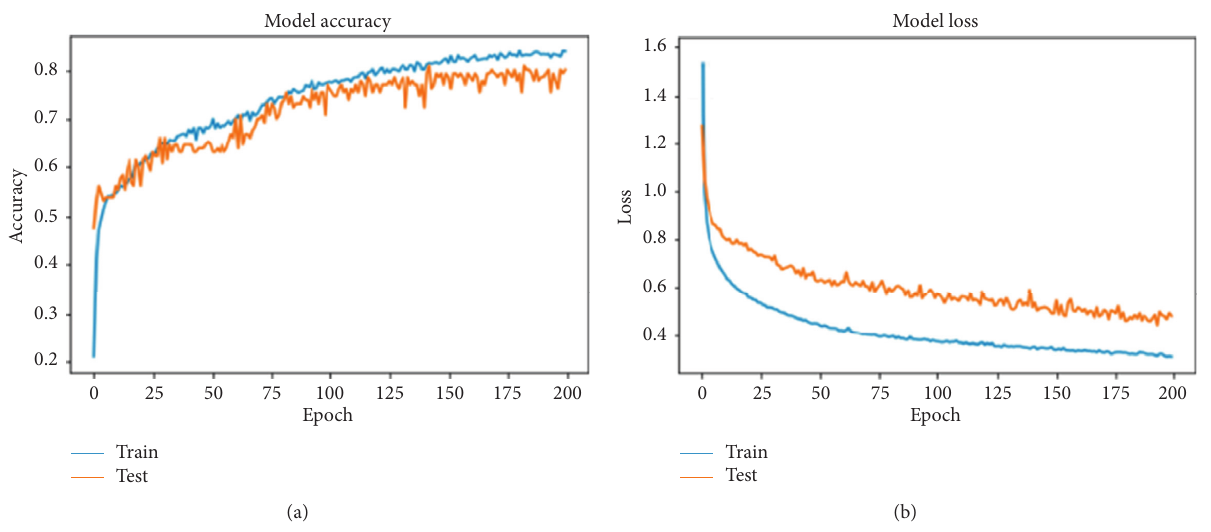
Figure 15: Model accuracy and model loss for M-learning model 4. (a) Model 4 accuracy. (b) Model 4